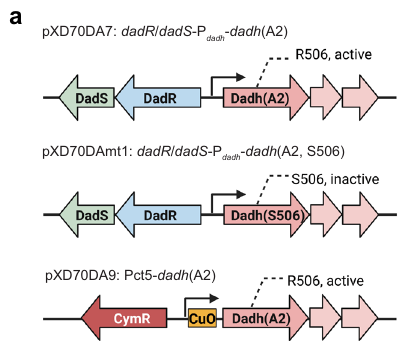
Fig. 4 | Introducing the active Dadh variant into the non-dopamine metabo- lizing strain E. lenta DSM 2243 results in dopamine dehydroxylation. a SchematicofpXD70DA7,pXD70DAmt1,andpXD70DA9constructs. b LC-MS/MS to quantify the production of dopamine dehydroxylation metabolite m -tyramine